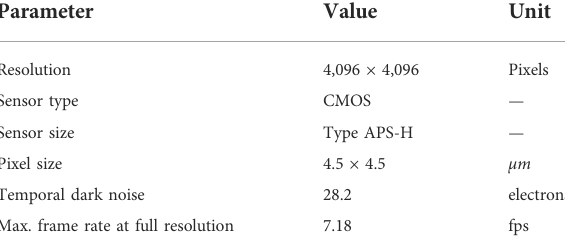
FIGURE 8 Test setup for the validation experiment. To the left, the robotic arm with the attached camera and illumination system is shown. In the centre, the mockup of a spacecraft with the applied Mantis Marker is visible. On the right the spotlight is visible. Note that during testing the illumination environment is controlled, not shown here.